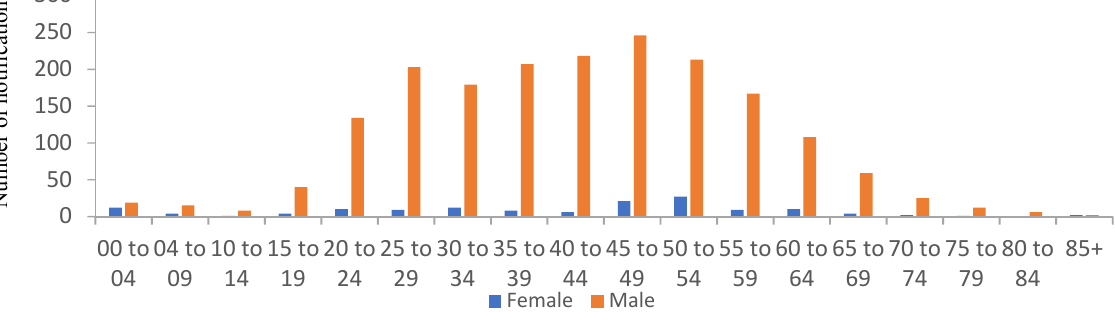
Figure 2. Total number of notifications to Victorian Health of blood lead levels measurements of persons reported above 5 µg/dL for the years spanning 2010–2018, grouped as a function of age group and sex. Source: https://www2.health.vic.gov.au.